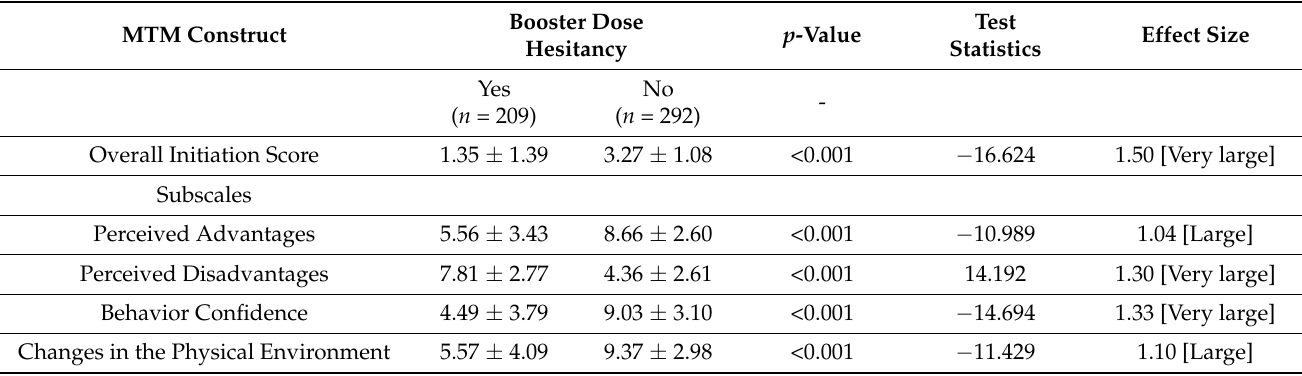
Table 4. MTM initiation and its subscale scores among COVID-19 booster dose hesitant and